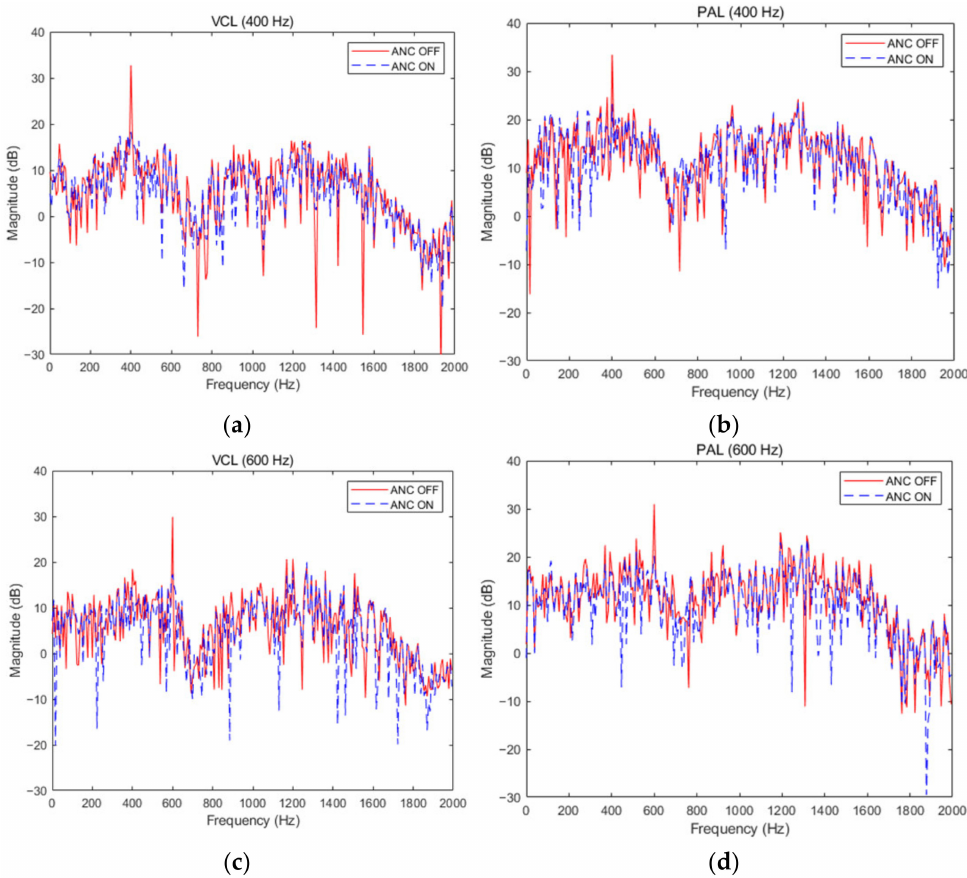
Figure 9. Noise reduction effect of traditional VCL and PAL at 400 Hz and 600 Hz. ( a ) VCL at 400 Hz; ( b ) PAL at 400 Hz; ( c ) VCL at 600 Hz; ( d ) PAL at 600